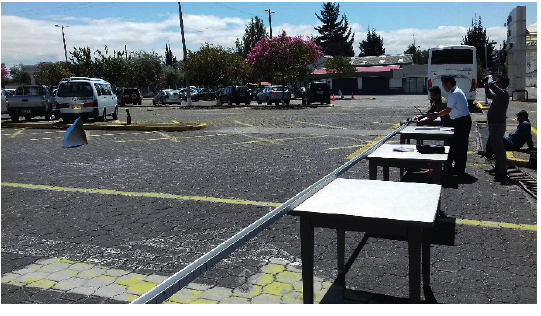
Figure 13. Capturing procedure snapshot.